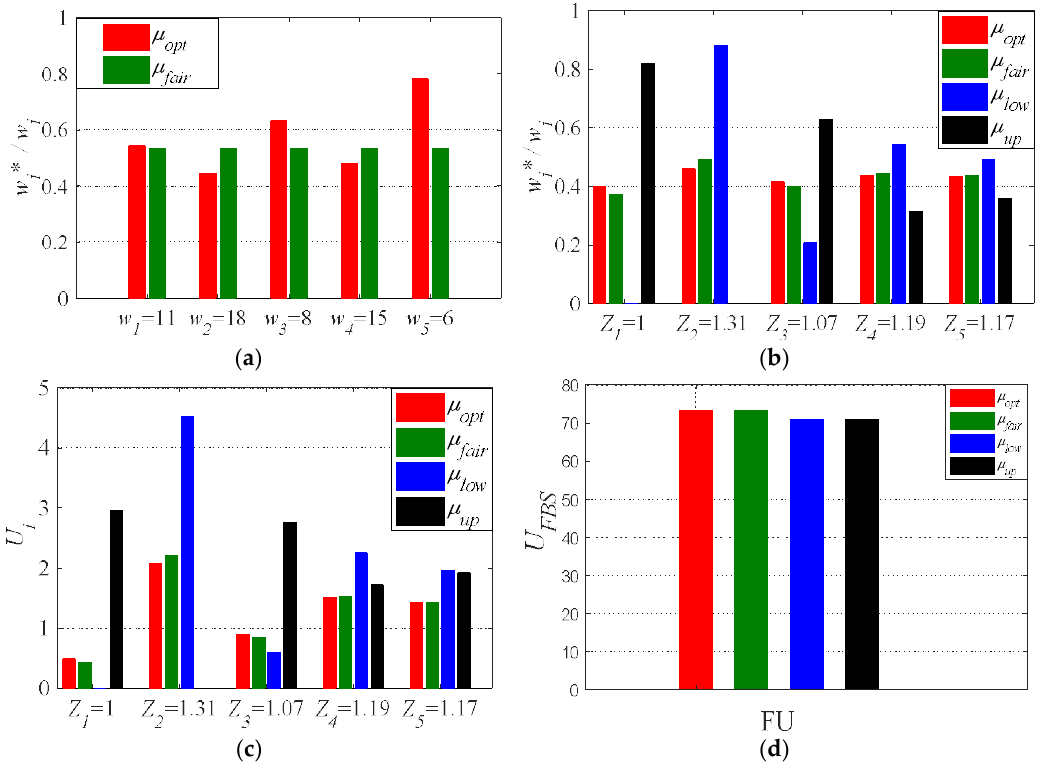
Figure 3 . Assignment of bandwidth to macro users ( a ) The ratio of the assigned bandwidth to desired one with different w i ; ( b ) The ratio of the assigned bandwidth to desired one with different priority; ( c ) Utility of each macro user; ( d ) Utility of FBS.